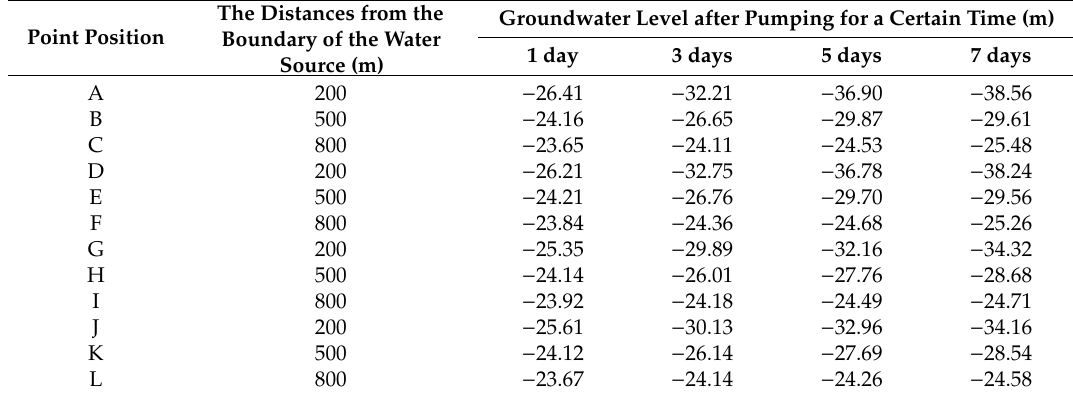
Table 5. Statistics of groundwater level changes around the water source during